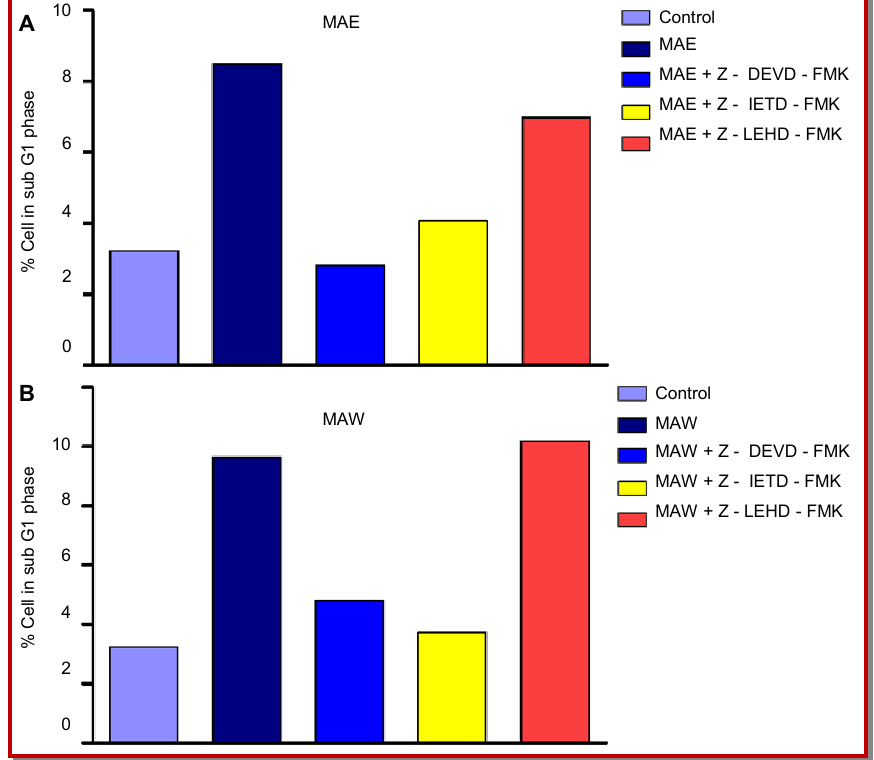
Figure 3: Effects of caspase inhibitors (caspase-3, -8 and -9 inhibitor) on the percentage of apoptotic HeLa cells after 24 hours treat- ment with ethanol extract (A) and with water extract